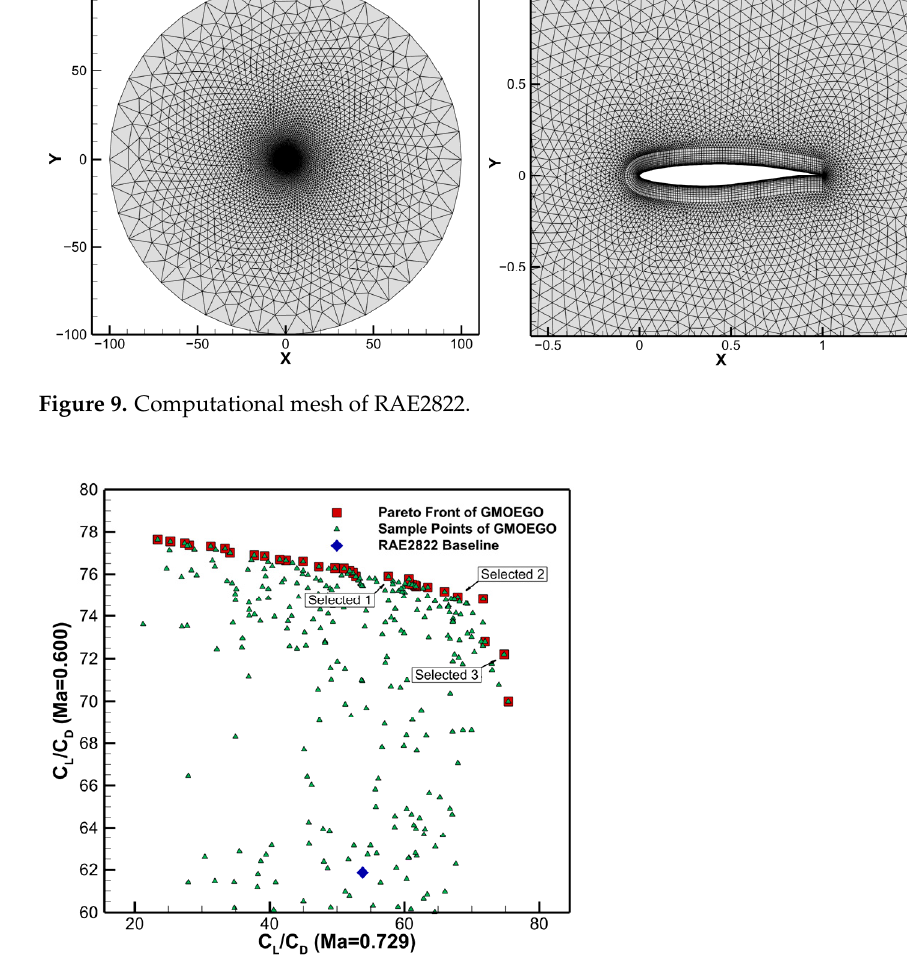
Figure 10. Optimization results of the GMOEGO algorithm.